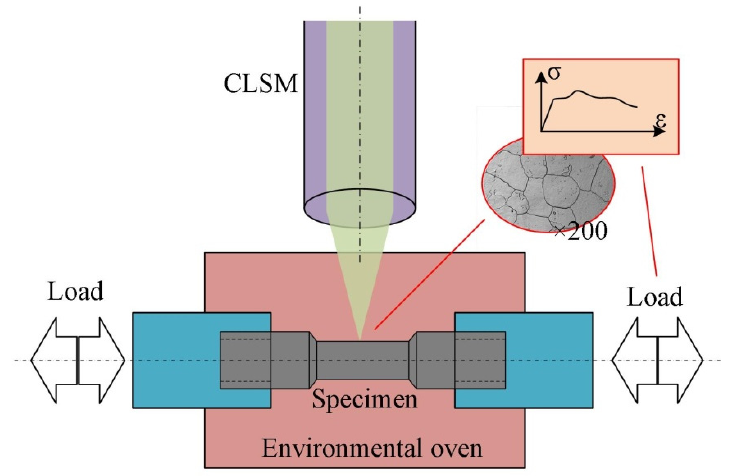
Figure 1. Illustration of the experimental setup.